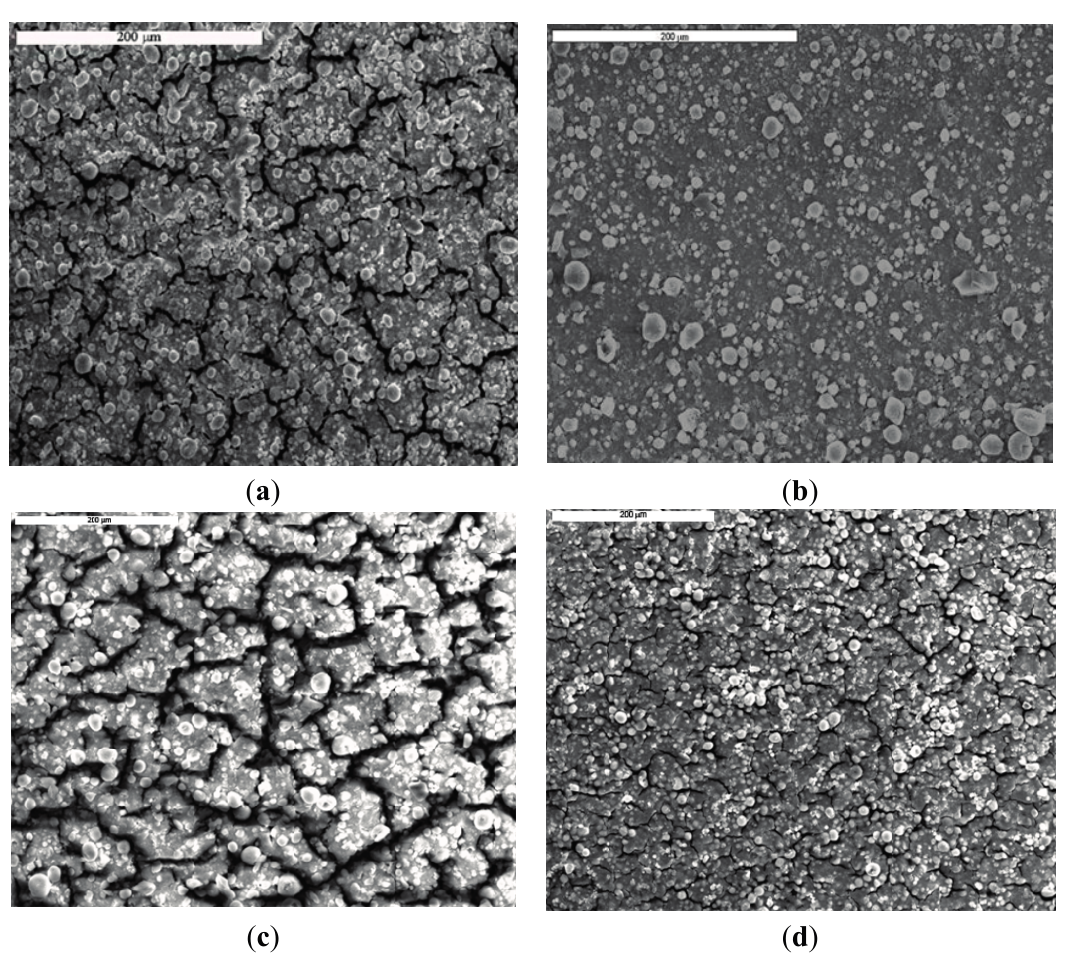
Figure 1. Scanning Electron Microscopy (SEM) micrographs of sintered